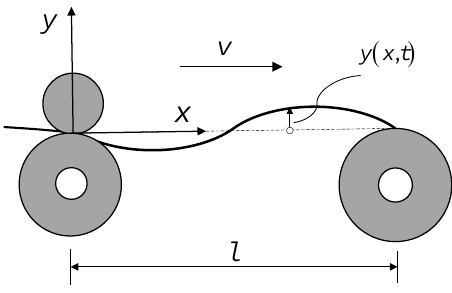
Figure 1. Axially moving string model.